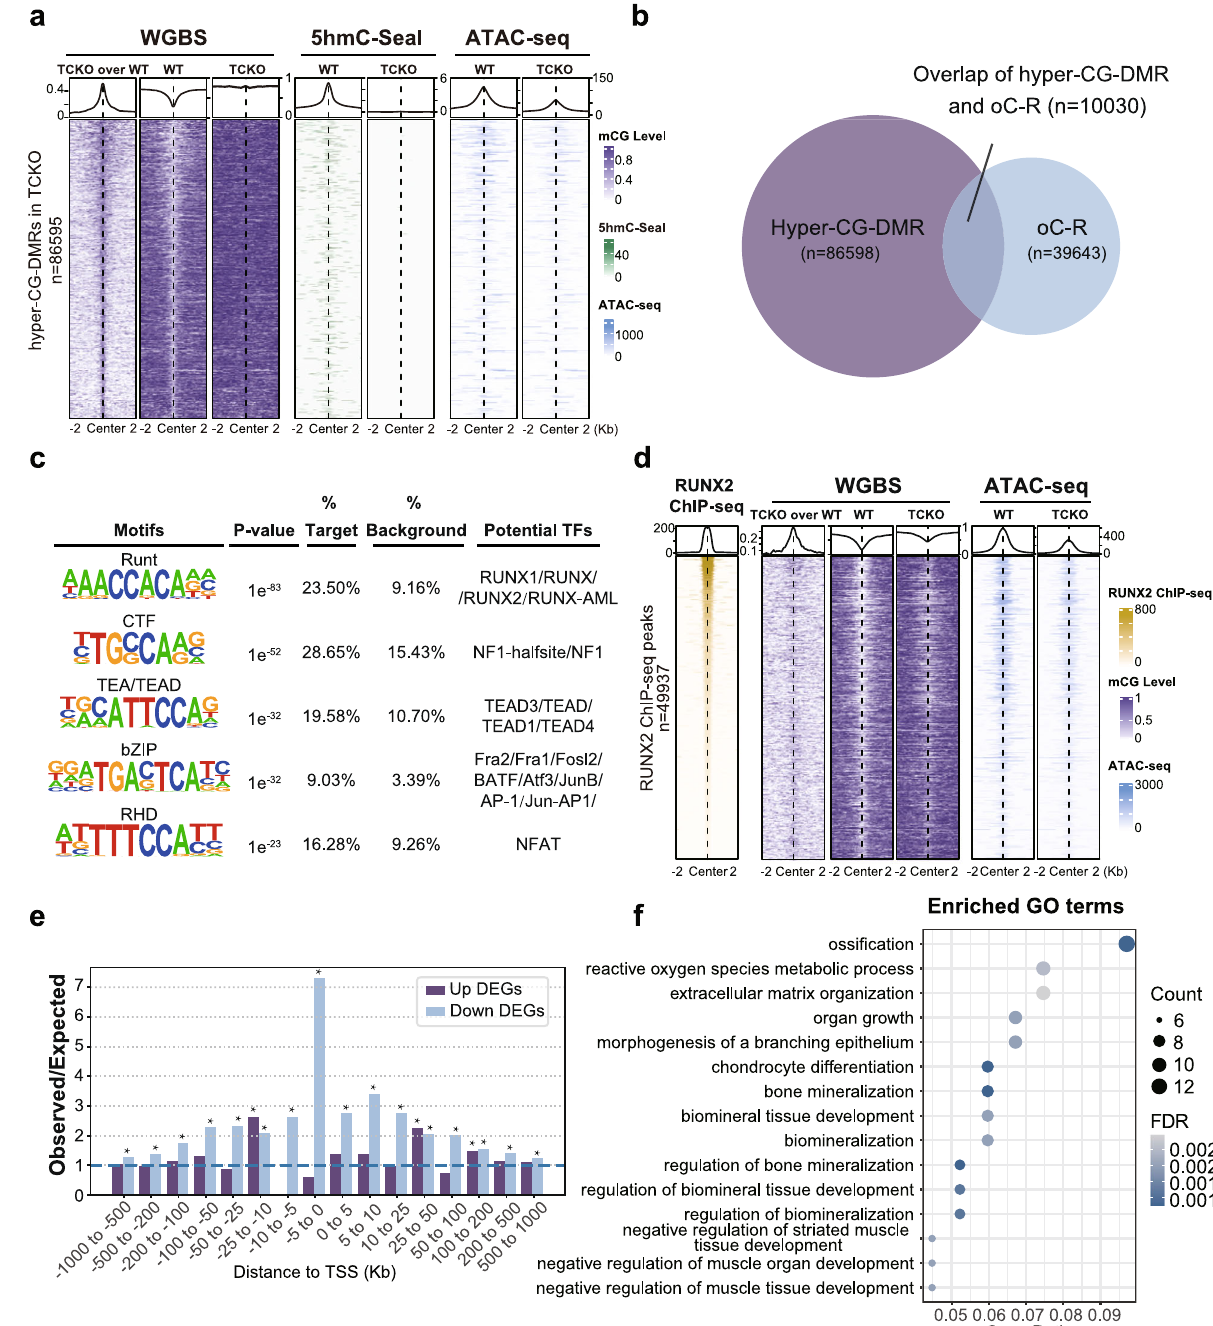
Fig. 5 | Association analysis of RNA-seq, WGBS, 5hmC-Seal, ATAC-seq, and RUNX2 ChIP-seq data suggests TET and RUNX2 proteins could synergistically promote osteogenesis. a Heatmap and metaplot of CG methylation level, 5hmC- Seal, and ATAC-seq signals over hyper-CG-DMR in TCKO cells. b Venn diagram of hyper-CG-DMR and chromatin Open-to-Close-Region (oC-R) in TCKO cells. c Top fi ve enriched known motifs and their potential transcription factors in overlapped regions of hyper-CG-DMR and chromatin oC-R in TCKO cells. d Heatmap and